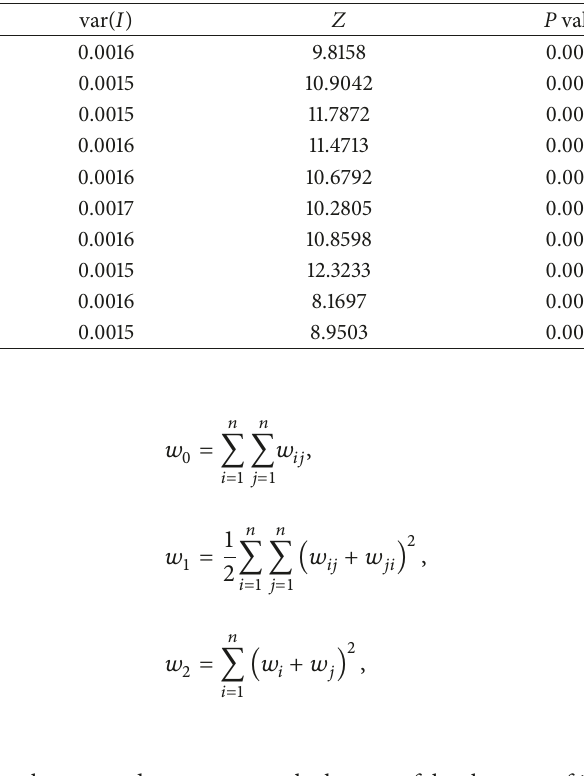
Table 2: Global Moran’s 𝐼 of environmental pollution index in 272 cities of China, 2003 to